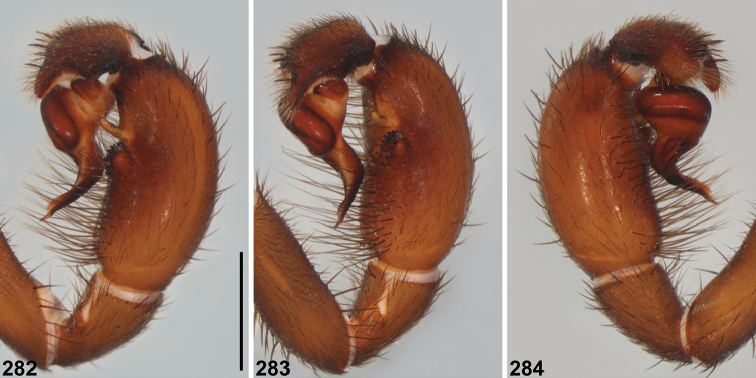

Idiosoma
kwongan sp. n., male holotype (WAM T27142) from E. of Greenhead (Western Australia; GES), pedipalp. 282 Retrolateral view 283 Retroventral view 284 Prolateral view. Scale bar 2.0.